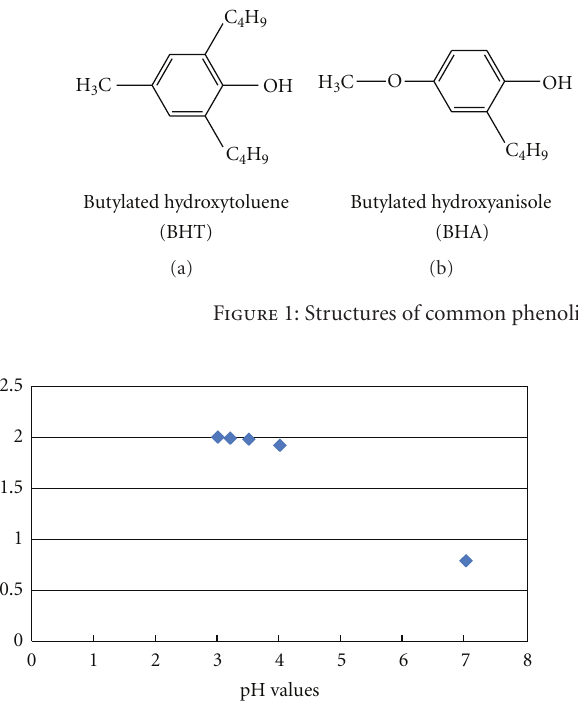
Figure 2: Variation of resolution factor between BHT and OMC at di ff erent pH values of phase B of mobile